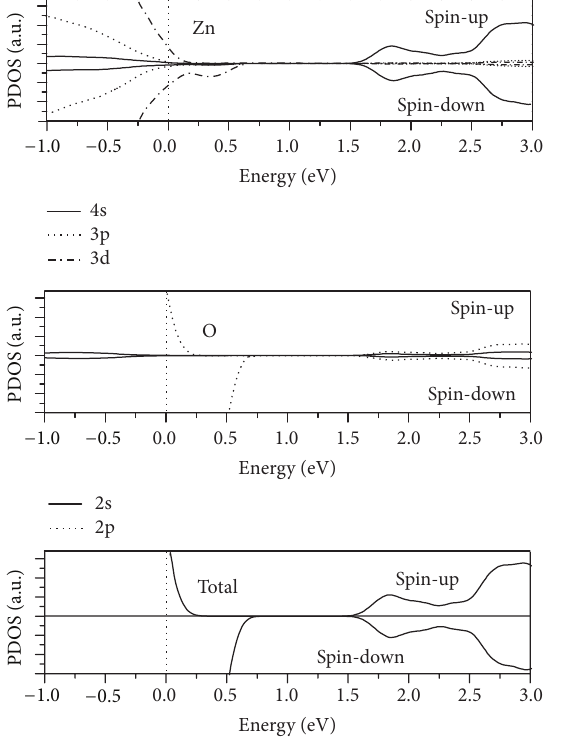
is the third- ai